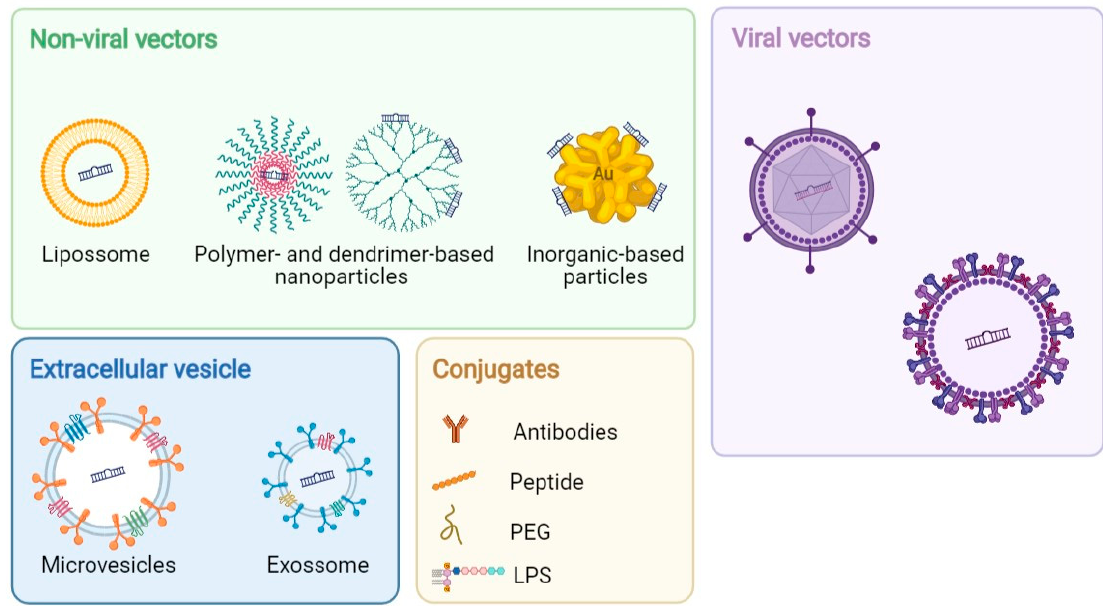
Figure 2. Schematic representation of the commonly used and emerging nanoplatforms for ncRNA delivery. (Abbreviations: PEG: polyethylene glycol and LPS: lipopolysaccharide).